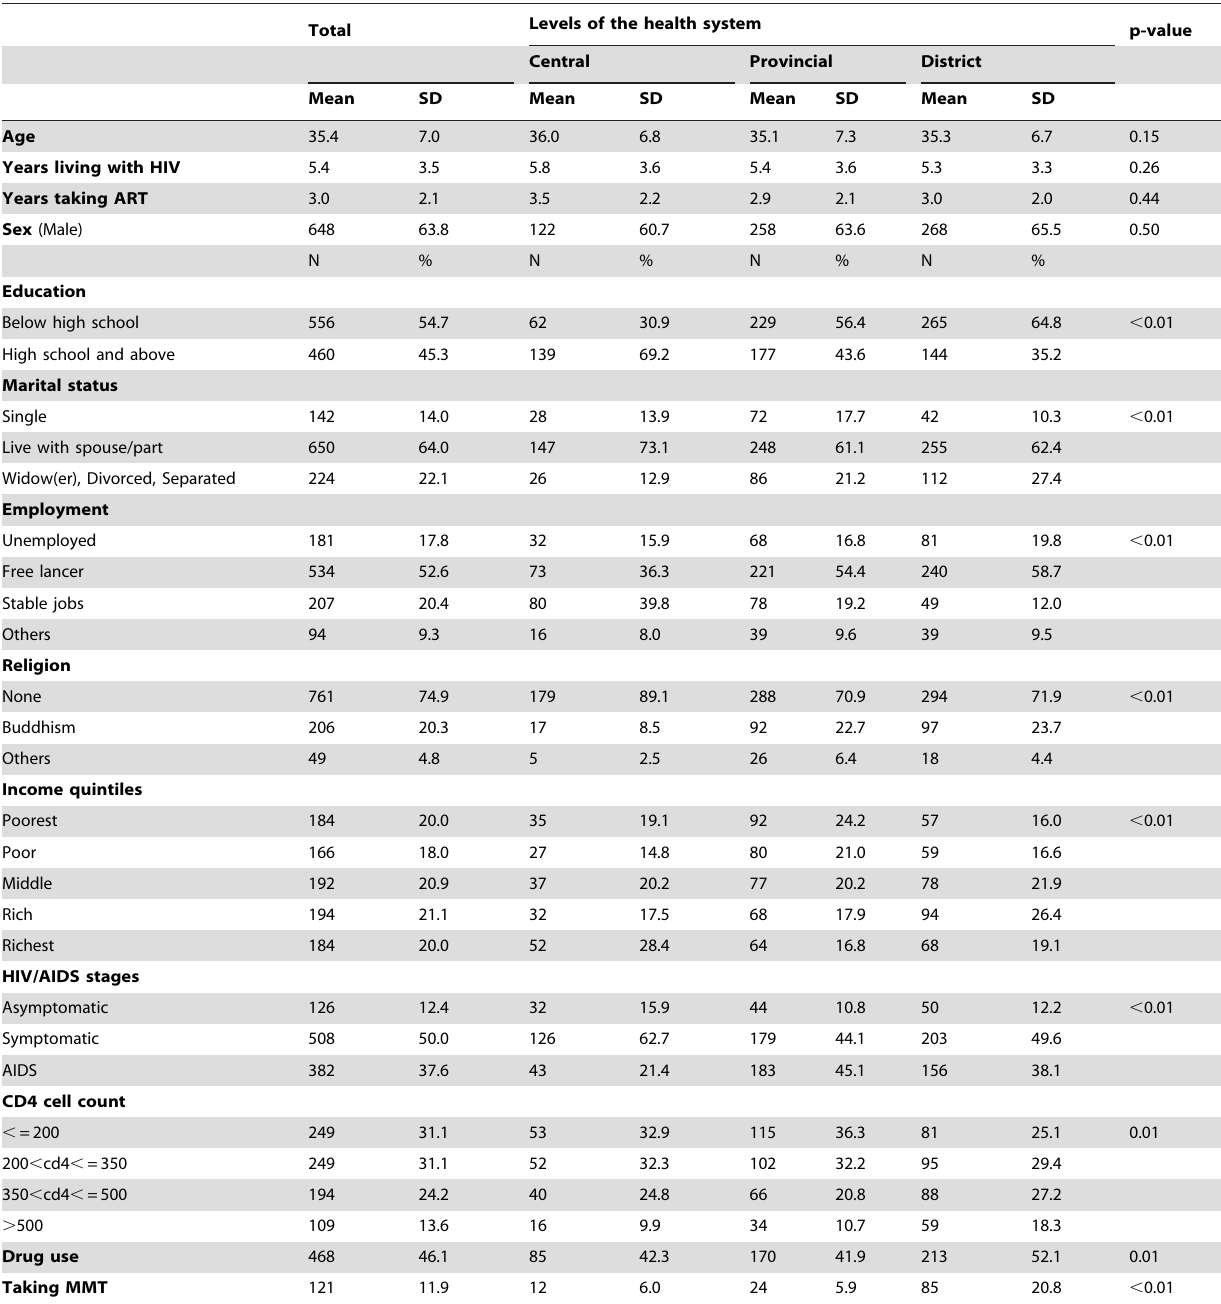
Table 1. Patient characteristics by levels of health system